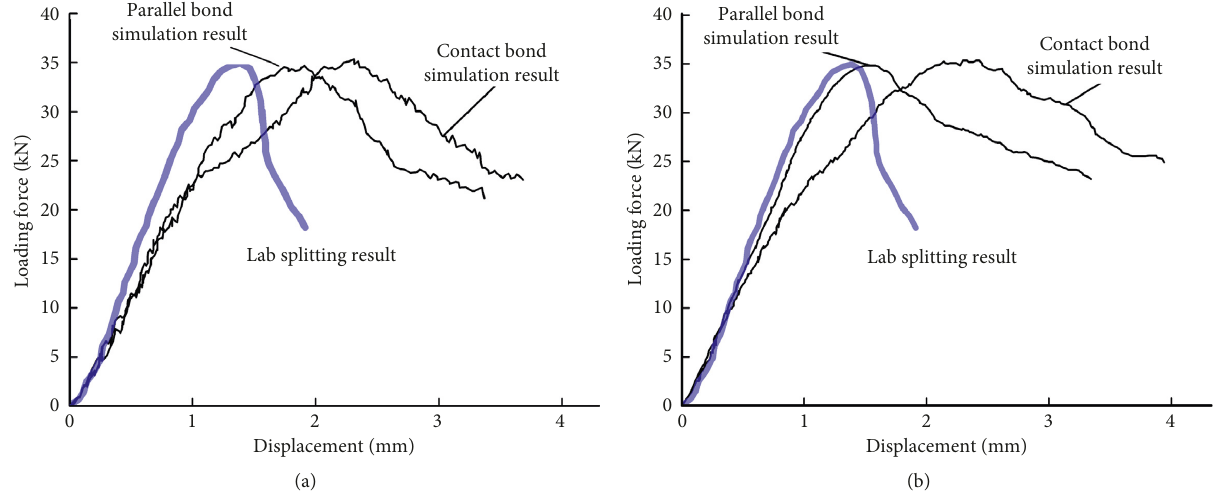
Figure 16: Comparison of the simulation results and lab test of AC-20 at 10 ° C. (a) 2D model. (b) 3D